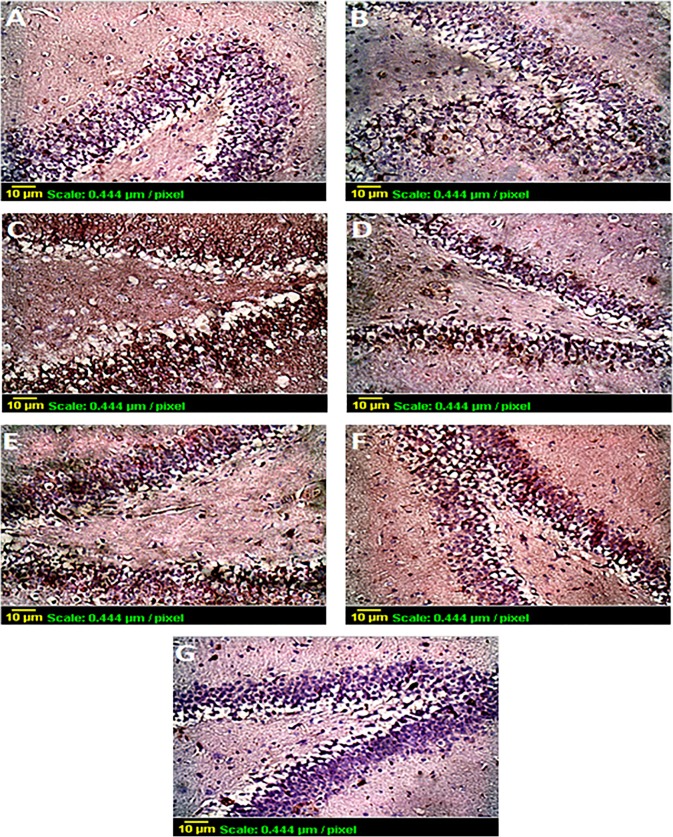
Immunohistochemical staining of hippocampal COX-2-positive cells immunized with goat-anti-rabbit antibodies of the sham group (A), control group (B), 3-NPA-treated group (C), 17β-estradiol- and 3-NPA-treated group (D), genistein (10 mg/kg)- and 3-NPA-treated group (E), genistein (20 mg/kg)- and 3-NPA-treated group (F) and genistein alone-treated group (G).